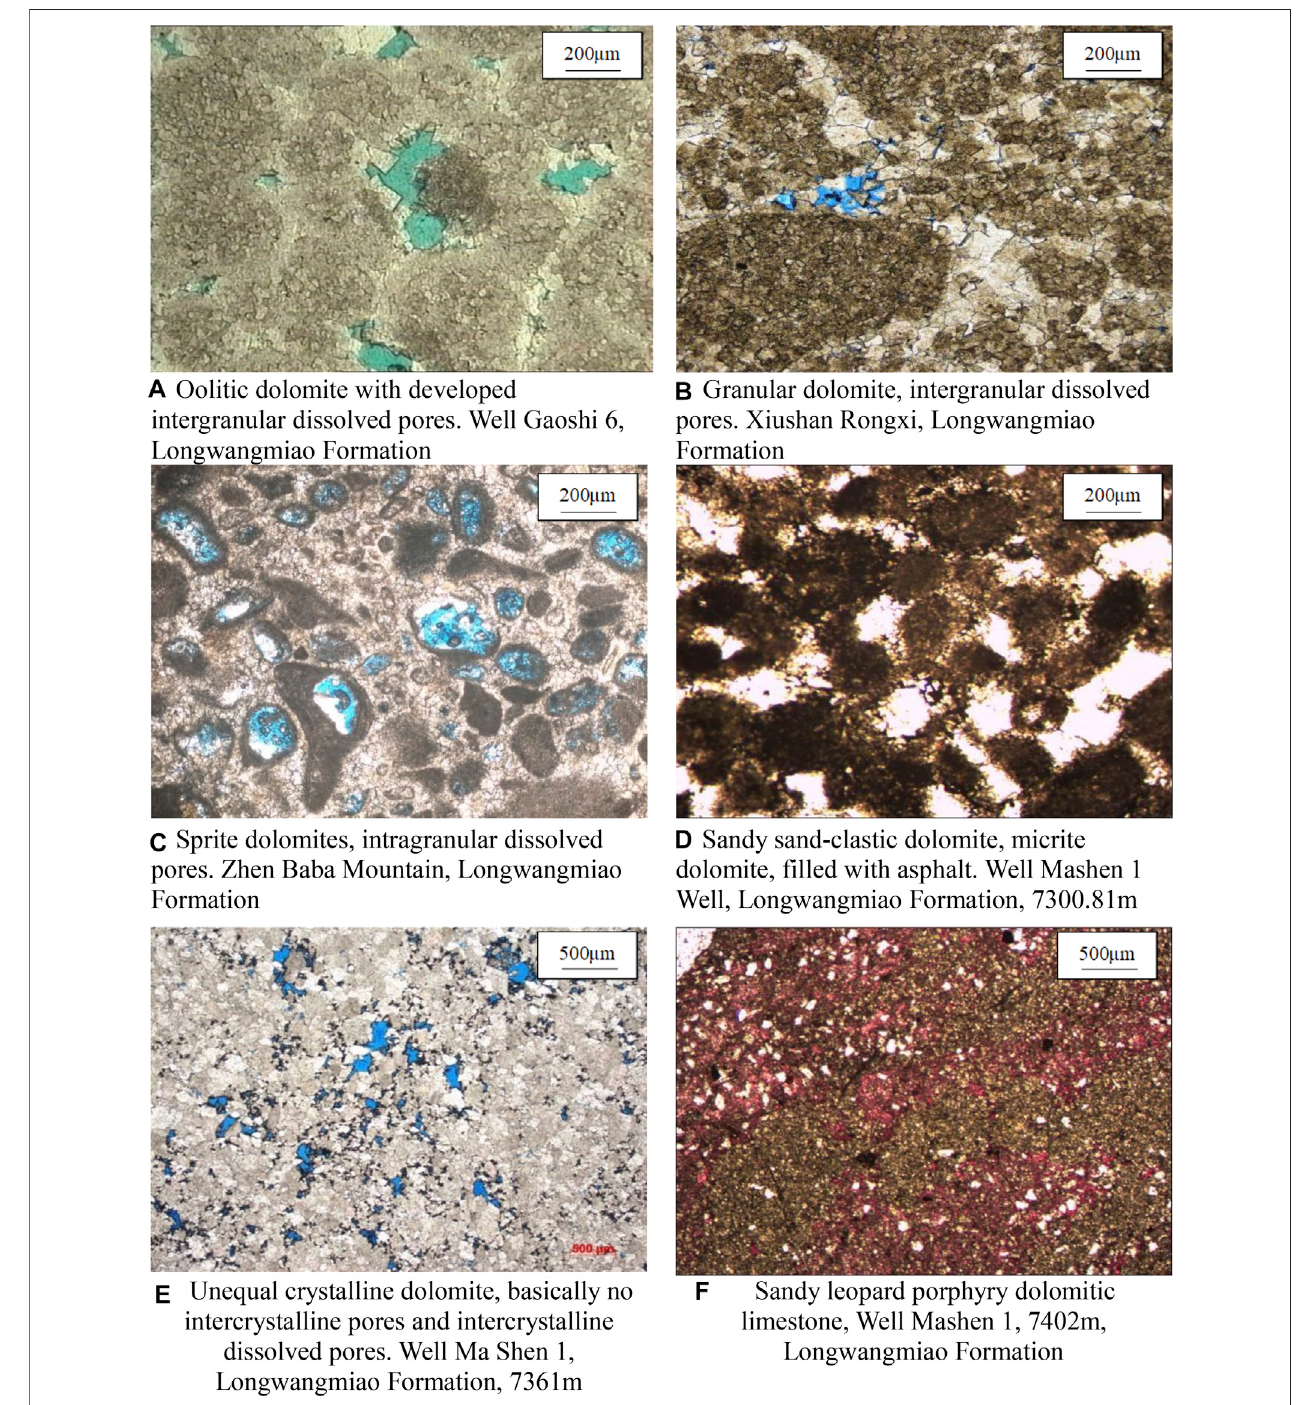
FIGURE2| ThepetrologicalcharacteristicsofCambriandolomiteinSichuanBasin. (A) .Ooliticdolomitewithdevelopedintergranulardissolvedpores. WellGaoshi 6, Longwangmiao Formation, (B) . Granular dolomite, intergranular dissolved pores. Xiushan Rongxi, Longwangmiao Formation, (C) . Sprite dolomites, intragranular dissolved pores. Zhen Baba Mountain, Longwangmiao Formation, (D) . Sandy sand-clastic dolomite, micrite dolomite, fi lled with asphalt. Well Mashen 1 Well, Longwangmiao Formation, 7,300.81 m, (E) . Unequal crystalline dolomite, basically no intercrystalline pores and intercrystalline dissolved pores. Well Ma Shen 1, Longwangmiao Formation, 7,361 m, (F) . Sandy leopard porphyry dolomitic limestone, Well Mashen 1, 7,402 m, Longwangmiao Formation.